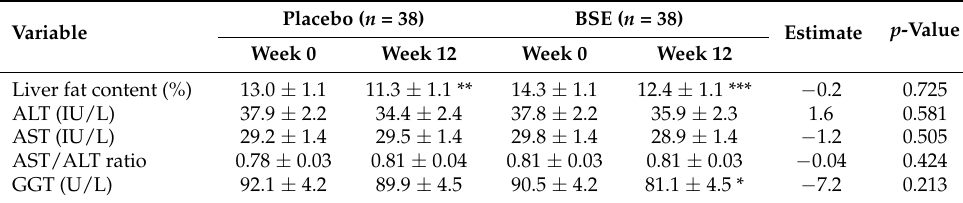
Estimate p -Value